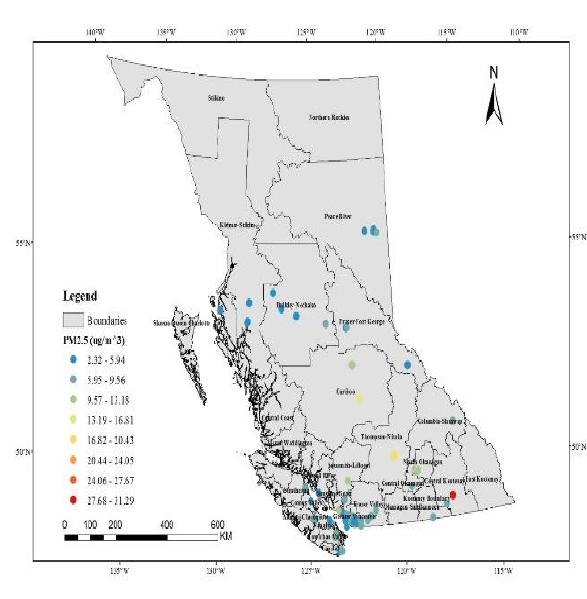
Fig. 3. Estimated PM 2.5 distribution maps generated by the GWR model in the year 2017 (top); Annual mean ground station measured PM 2.5 concentrations